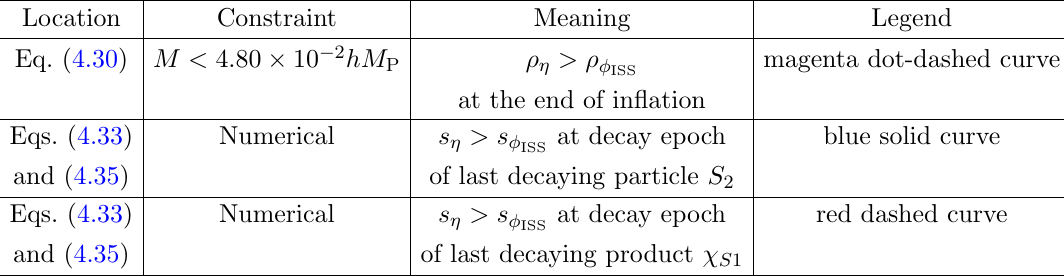
Table 4 . The constraints on the ISS parameters M and h obtained in this section to have acceptable entropy production, their location in the text, their meaning, and their depiction in the (cid:12)gures of this